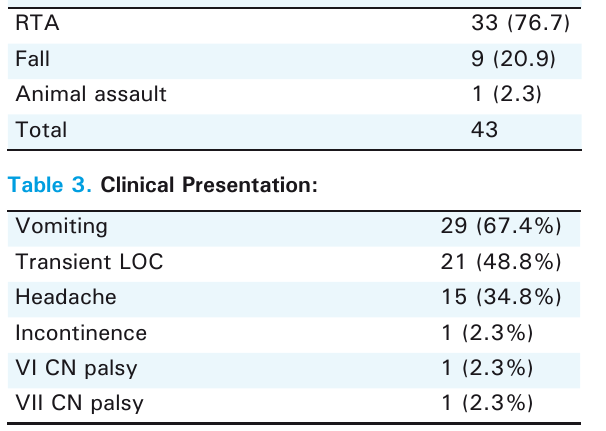
table 4. State of Consciousness